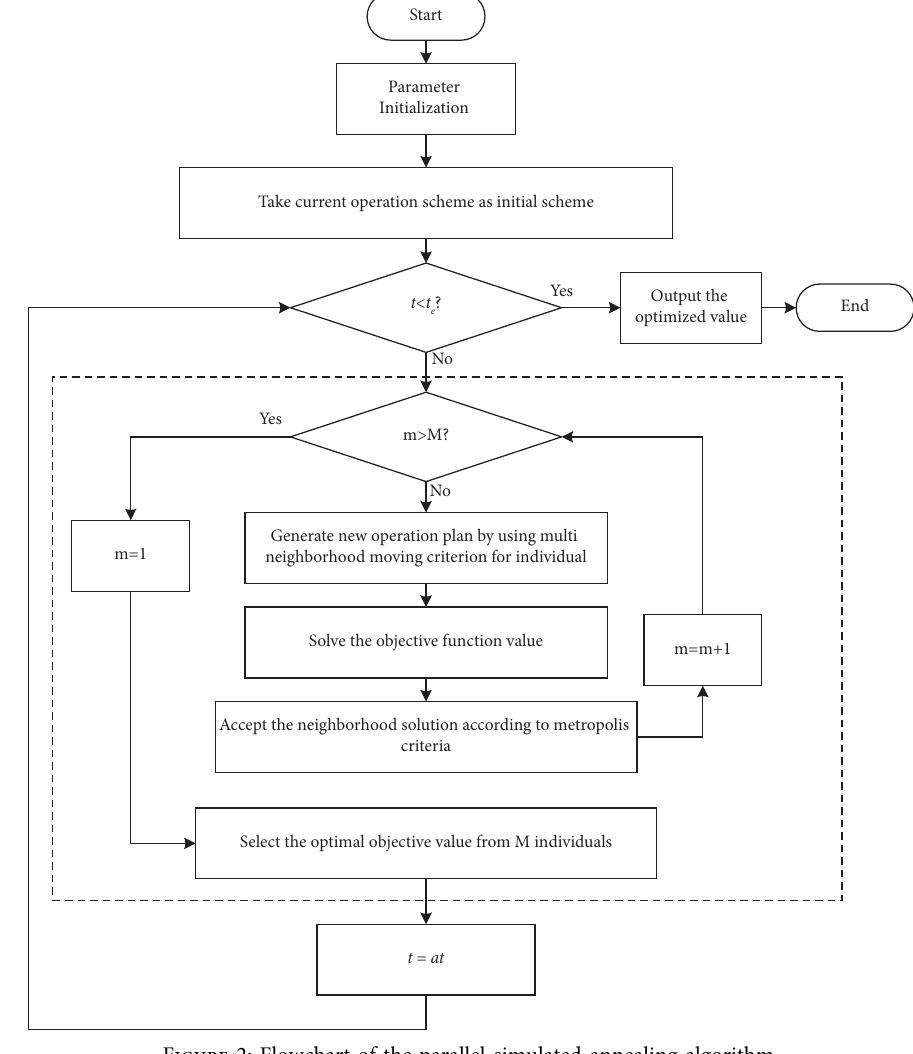
Figure 2: Flowchart of the parallel-simulated-annealing